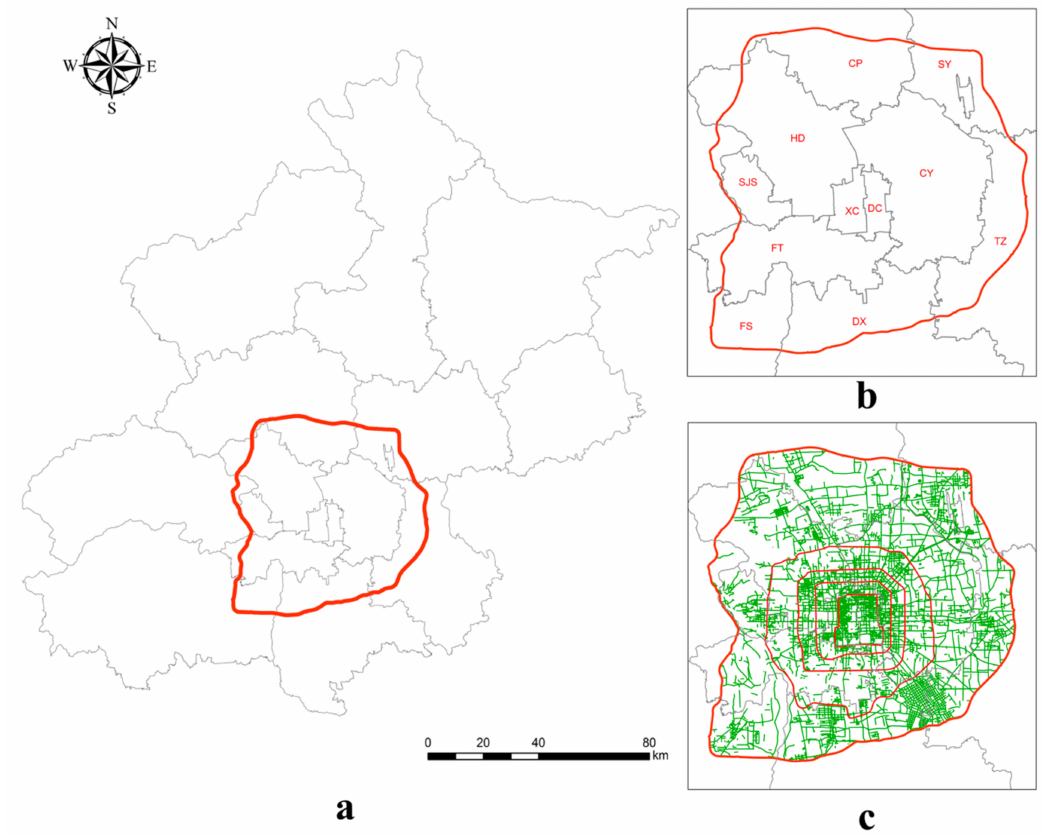
Figure 1. Study area in Beijing city. XC: Xicheng district, DC: Dongcheng district, HD: Haidian